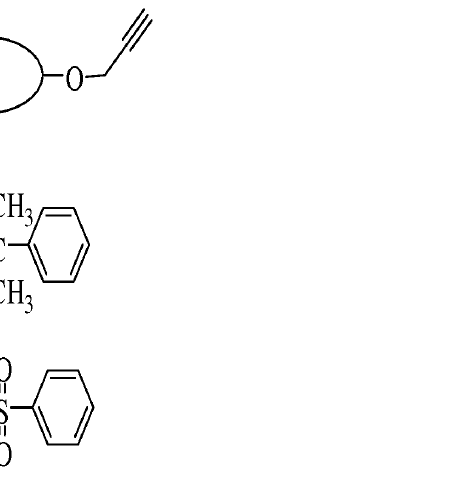
Fig. 2. Synthesis of compounds 4a–b.